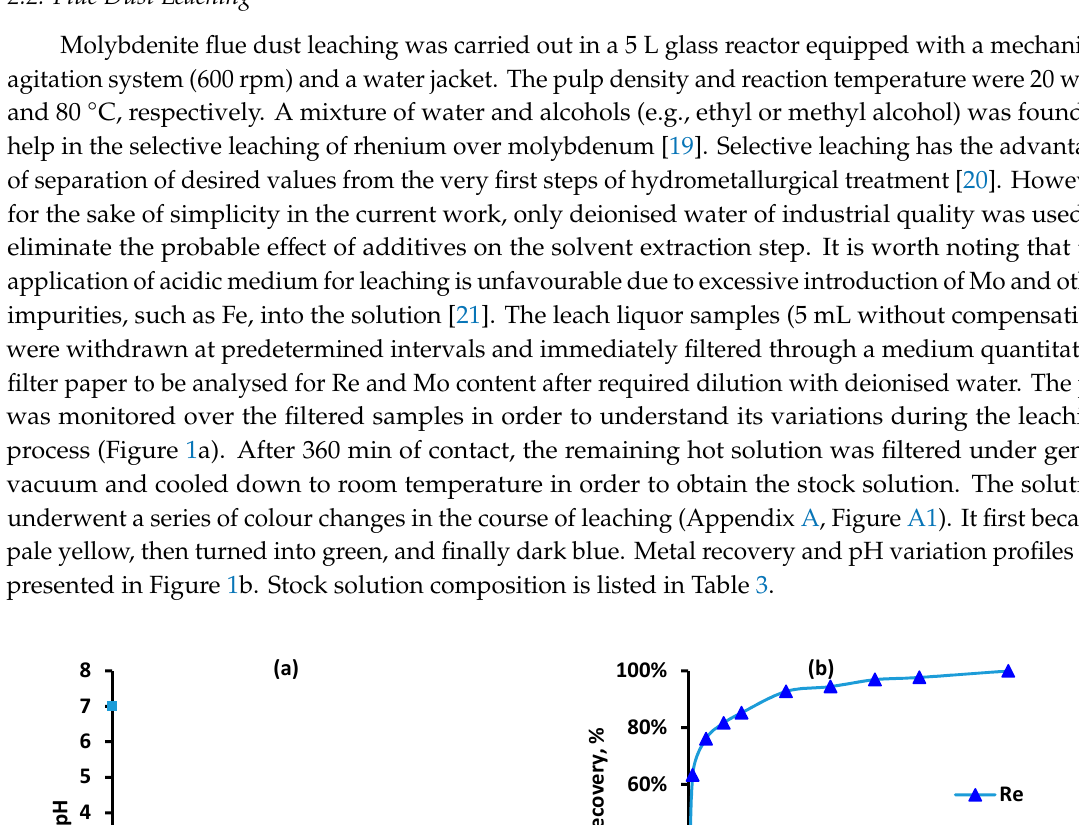
Table 2. Composition of flue dust before leaching (ppm).